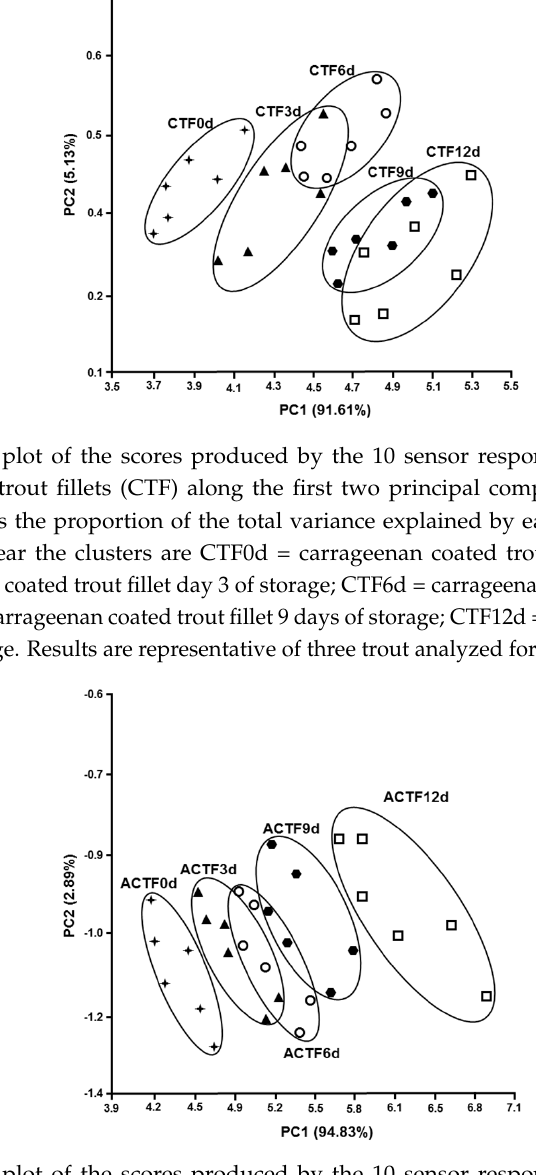
Table 3. Correlation Matrix among the uncoated trout fillets (UTF). The numbers indicate the discrimination indexes.